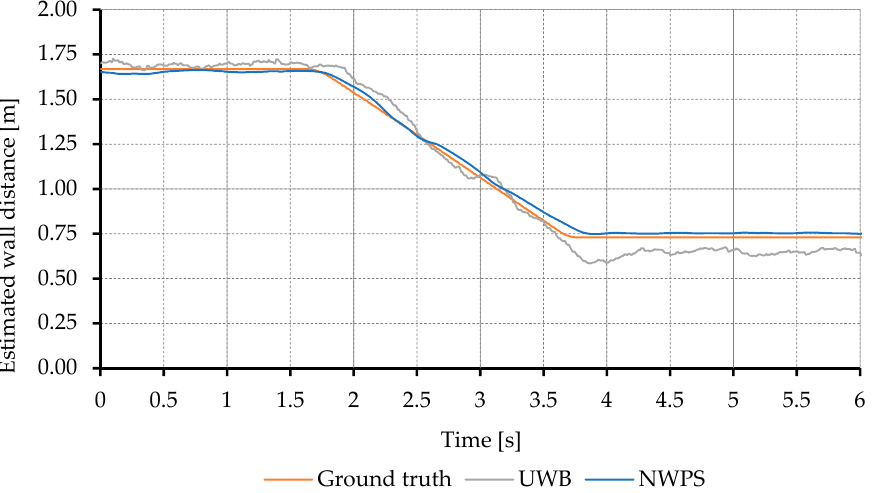
Figure 6. Estimation of the distance to the wall in 20-degree approaching maneuvers at 0.5 m/s. Comparison between conveyor belt measurements and the estimations from the UWB and the proposed NWPS.